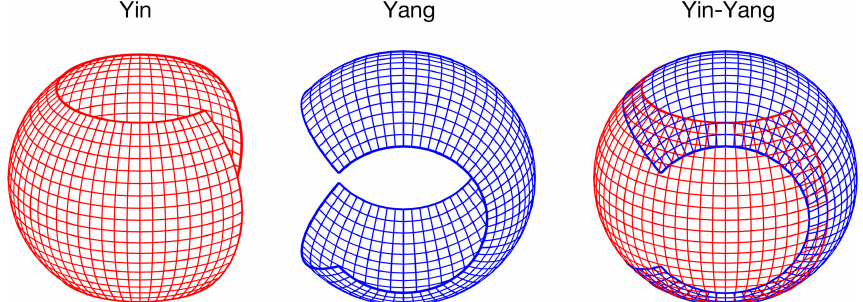
Figure 5. The Yin–Yang grid is a combination of two limited-domain latitude–longitude grids assembled to provide complete coverage of the sphere.